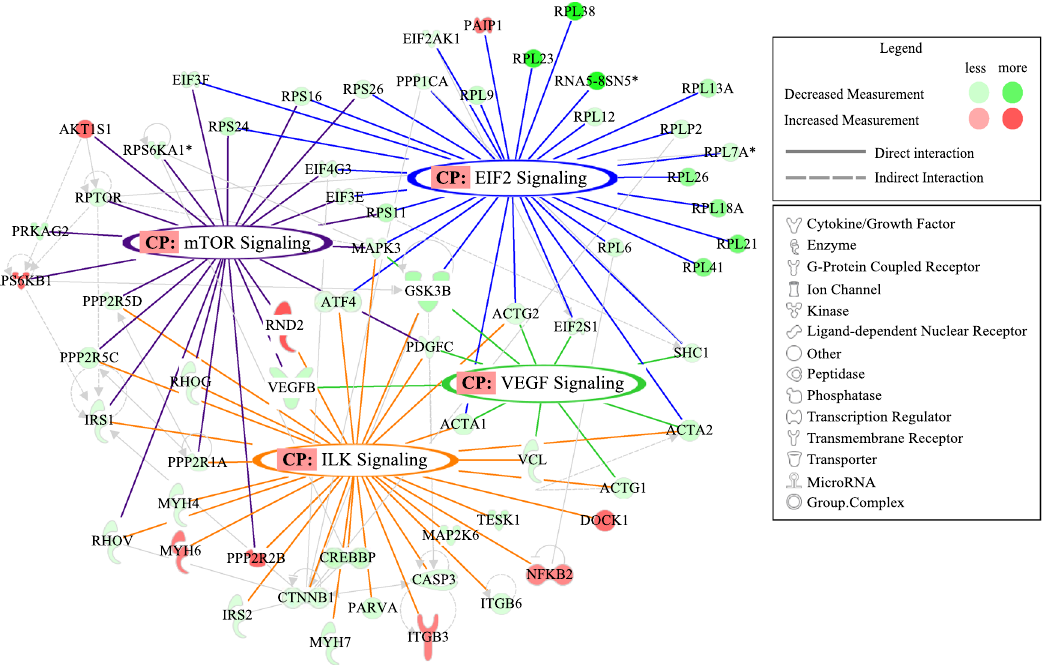
Figure 3. Differentially expressed genes between Native Hawaiians and Japanese reveal Early Response Sepsis (ERS) genes involved in viral infection. Network of top canonical pathways EIF2, mTOR, ILK and VEGF and interactions between associated genes identified by IPA. CP canonical